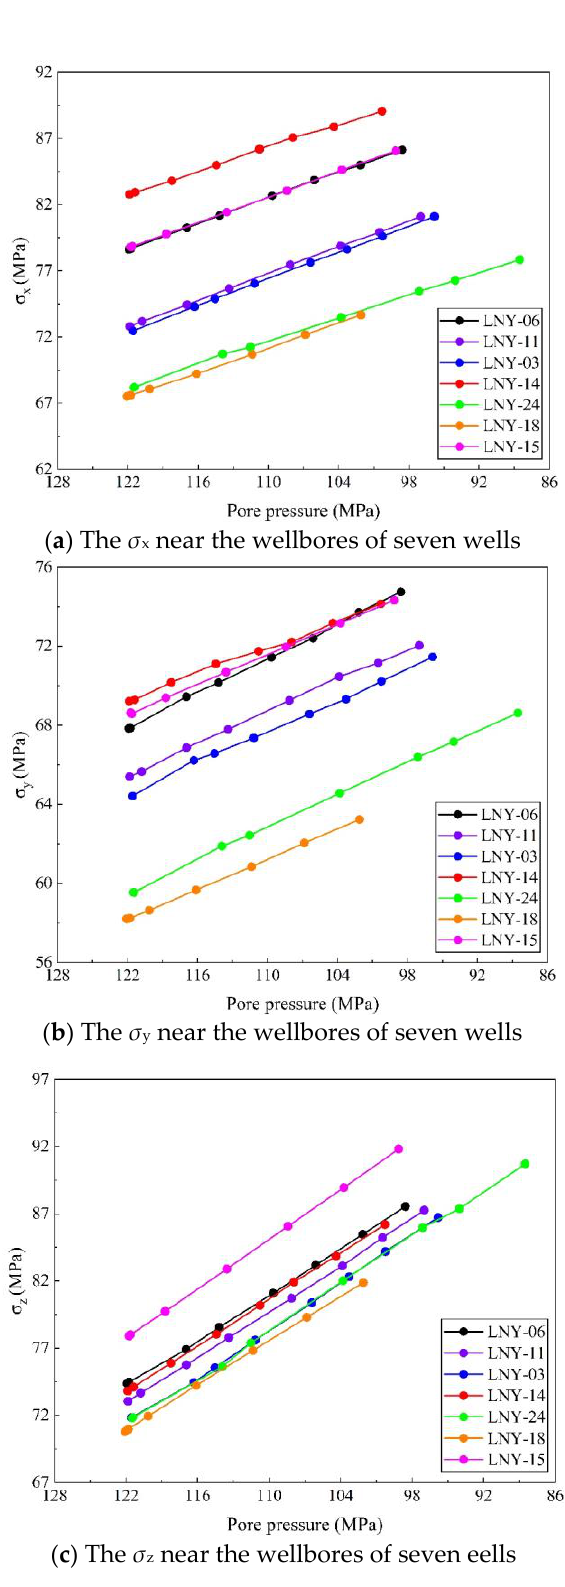
Figure 11. Three-dimensional effective stress near the wellbores of seven wells. The deformation of natural fractures and faults during the development was simulated. The initial conditions of natural fracture and fault deformation variables were both set to zero. After 2090 days of development, the elastic normal strain and elastic shear strain of the faults were about 3.0 × 10 −7 ~1.0 × 10 −6 and 2.0 × 10 −7 ~8.0 × 10 −7 , respectively, and the shear strain was smaller than the normal strain. The variation in plastic normal and plastic shear strain of the faults was zero, indicating that the fault had not reached the damage slip stage, as shown in Figures 12 and 13. The elastic normal strain and elastic shear strain of the natural fractures were about 1.0 × 10 −7 ~4.0 × 10 −7 and 2.0 × 10 −8 ~1.0 × 10 −7 , respectively, and the variation of plastic normal and shear strain of the natural fractures was zero, indicating that the natural fractures also did not reach the damage slip stage during the development process, as shown in Figures 14 and 15. ( a ) Normal strain ( b ) Shear strain Figure 12. Elastic strain distribution of faults in the target formation. ( a ) Normal strain 5.0 10 × -6 4.0 10 × -6 3.0 10 × -6 2.0 10 × -6 0 Strain 1.0 10 × -6